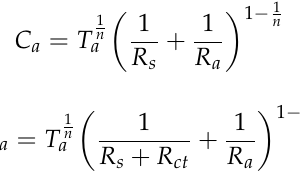
electrochemically active surface